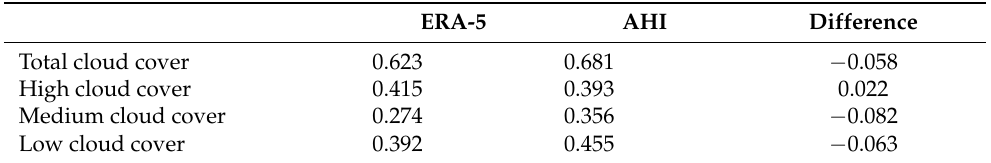
Figure 10. Annual average daytime high, medium and low cloud covers from ( a – c ): the ERA- 5 reanalysis data and ( d – f ): Advanced Himawari Imager (AHI) measurements. The differences between observation and reanalysis for LCC is shown in ( g – i ). Table 2. Annual average daytime total cloud cover (TCC) and layered cloud cover (LCC) for ERA-5 reanalysis and Advanced Himawari Imager (AHI) measurements in